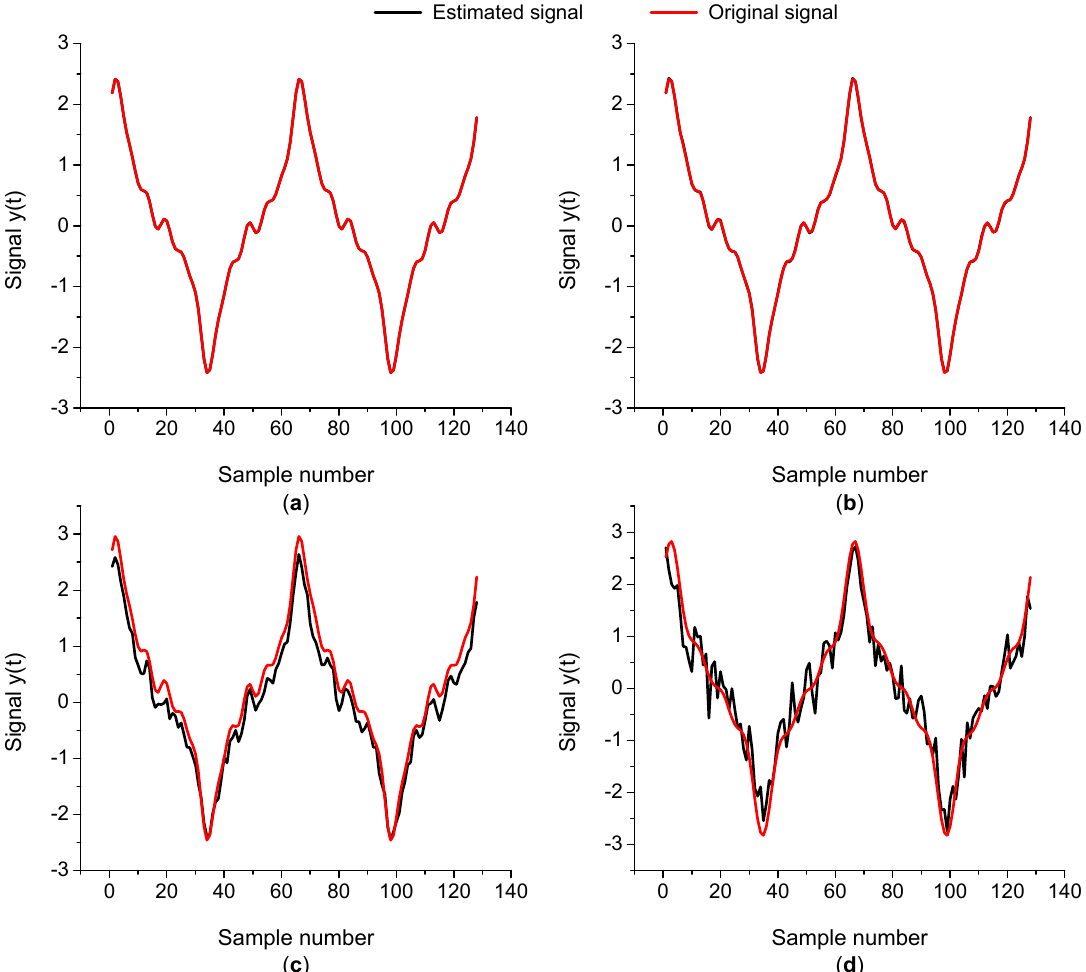
Figure 6. Actual and Estimated signal comparison ( a ) non-noisy, ( b ) 40 dB noise level, ( c ) 20 dB noise level, and ( d ) 10 dB noise level. Table 5. GWO-LS Numerical Comparison for Case Study I.